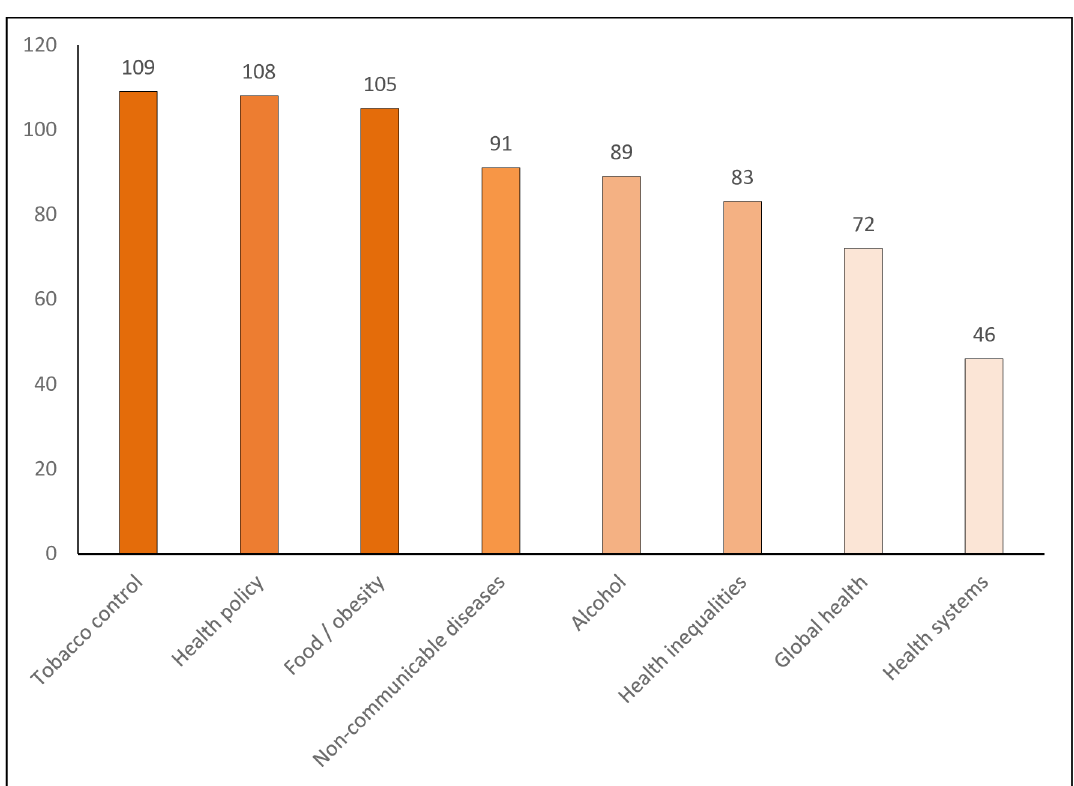
Fig 1. Foci of respondents current work (number of respondents in each